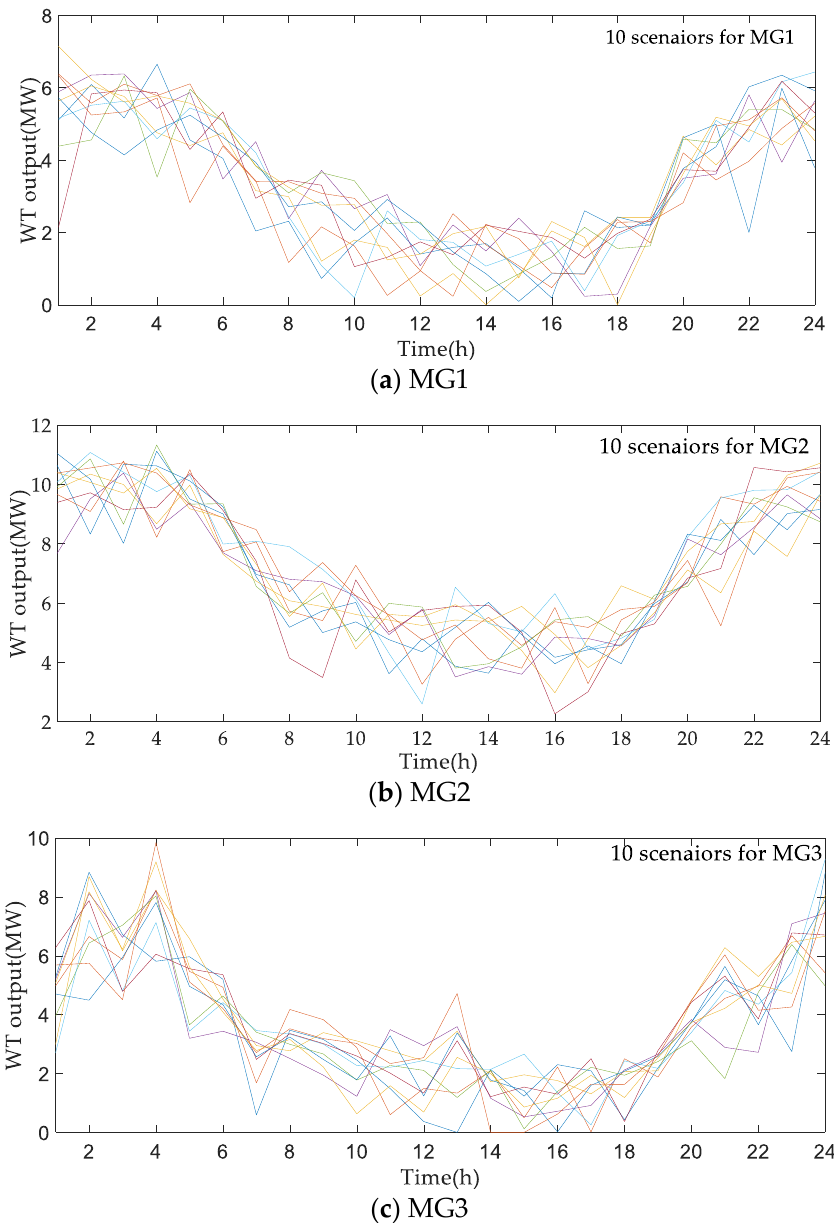
Figure 3. Stochastic scenarios for wind power generation in MGs. Table 1. Technical parameters of MG.